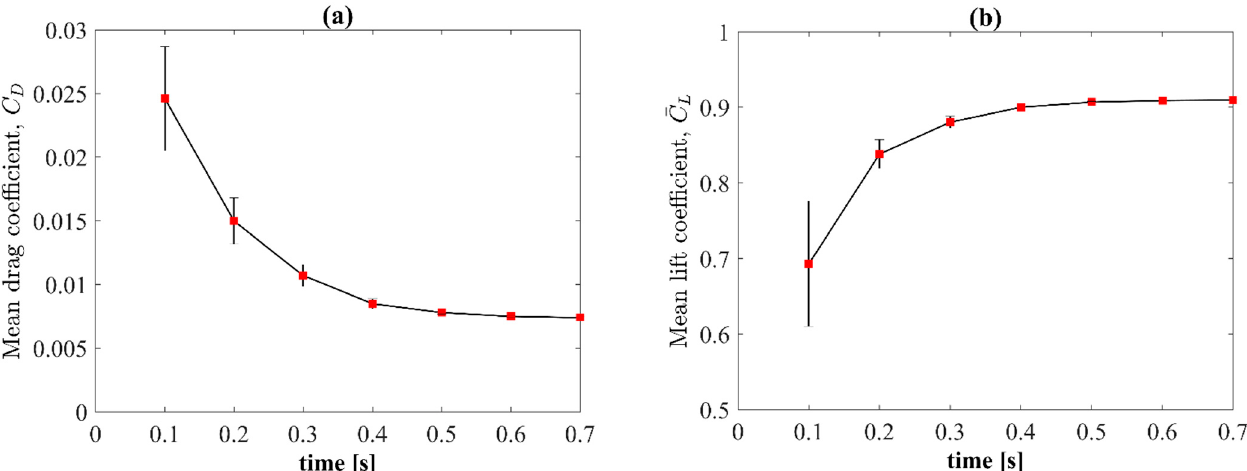
Figure 3. The averaged aerodynamic force coefficients and their standard deviation at the angle of attack of 4°: ( a ) lift coefficient; ( b ) drag coefficient.